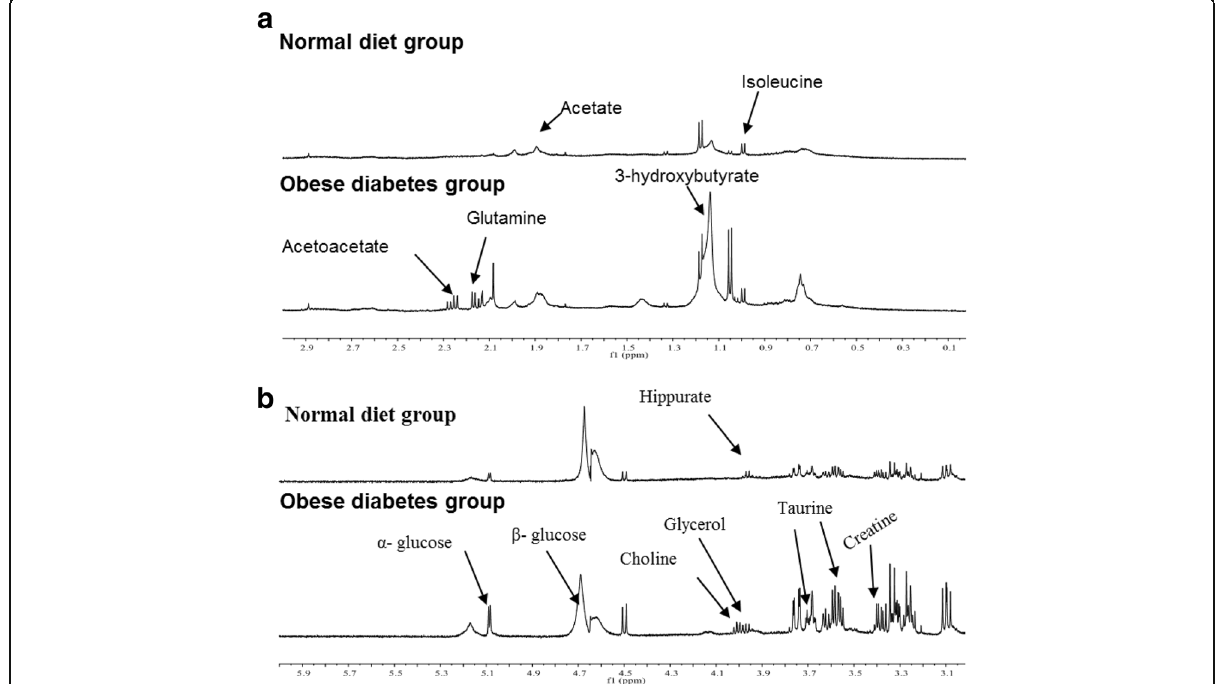
Fig. 6 Typical 500 MHz 1 HNMR serum a (0 to 3 ppm) and b (3 to 6 ppm) spectra collected from obese diabetes group (DG) and normal diet group (NG) Sprague Dawley rats before treatment